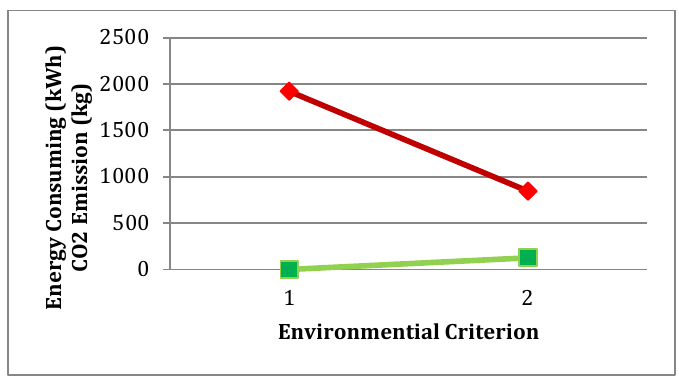
Figure 8: Alternative based criterion weight